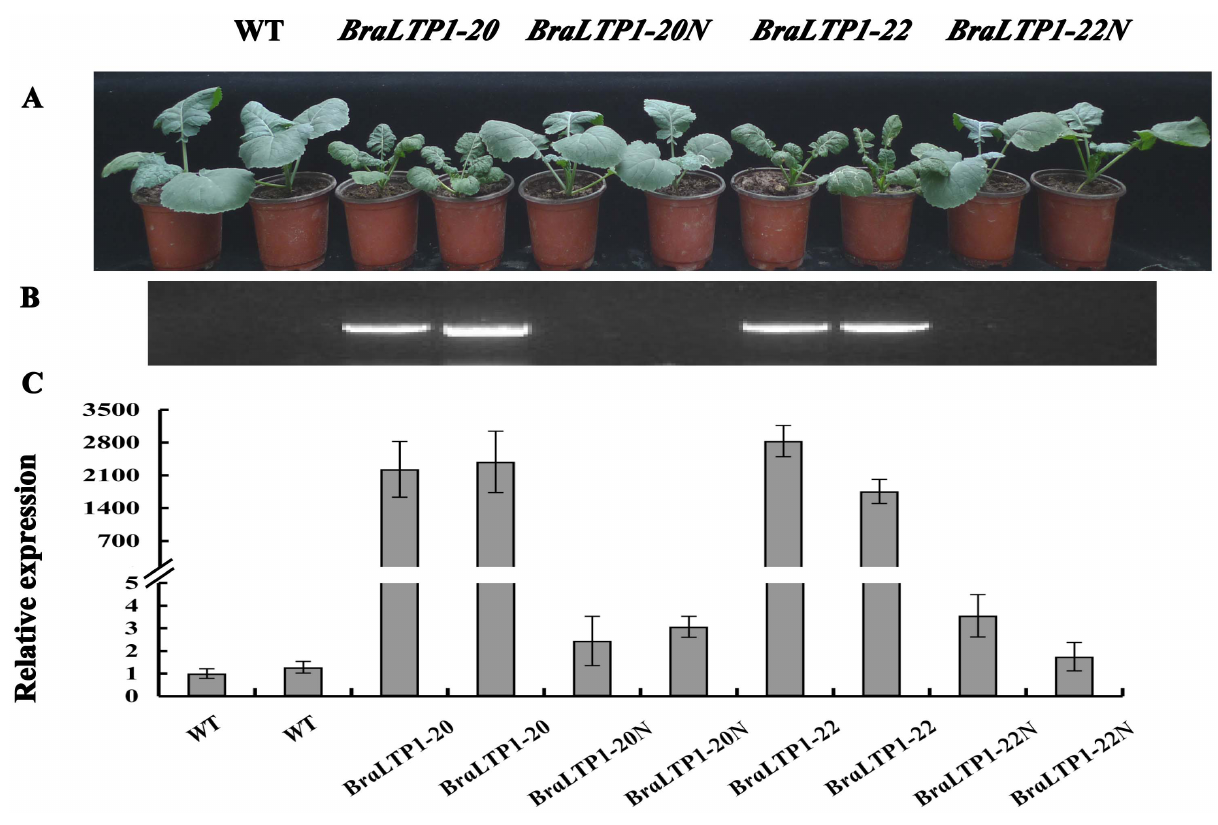
Figure 3. Cosegregation experiments of two 35S::BraLTP1 transgenic lines. (A) Phenotype of 5-week-old T1 plants segregating for BraLTP1 - 20 and BraLTP1 -22. (B) PCR results using primers spanning the CaMV 35S promoter and BraLTP1 in the vector, with DNA of corresponding plant in panel (A) as templates. (C) Transcript level of BraLTP1 for each plant shown directly above in panel (A). PCR-positive transformants show high BraLTP1 - expression and displayed the typical overexpression phenotypes including dark-green, wrinkled, curly leaves and smaller stature compared with their negative segregants ( BraLTP1-20N and BraLTP1-22N ).